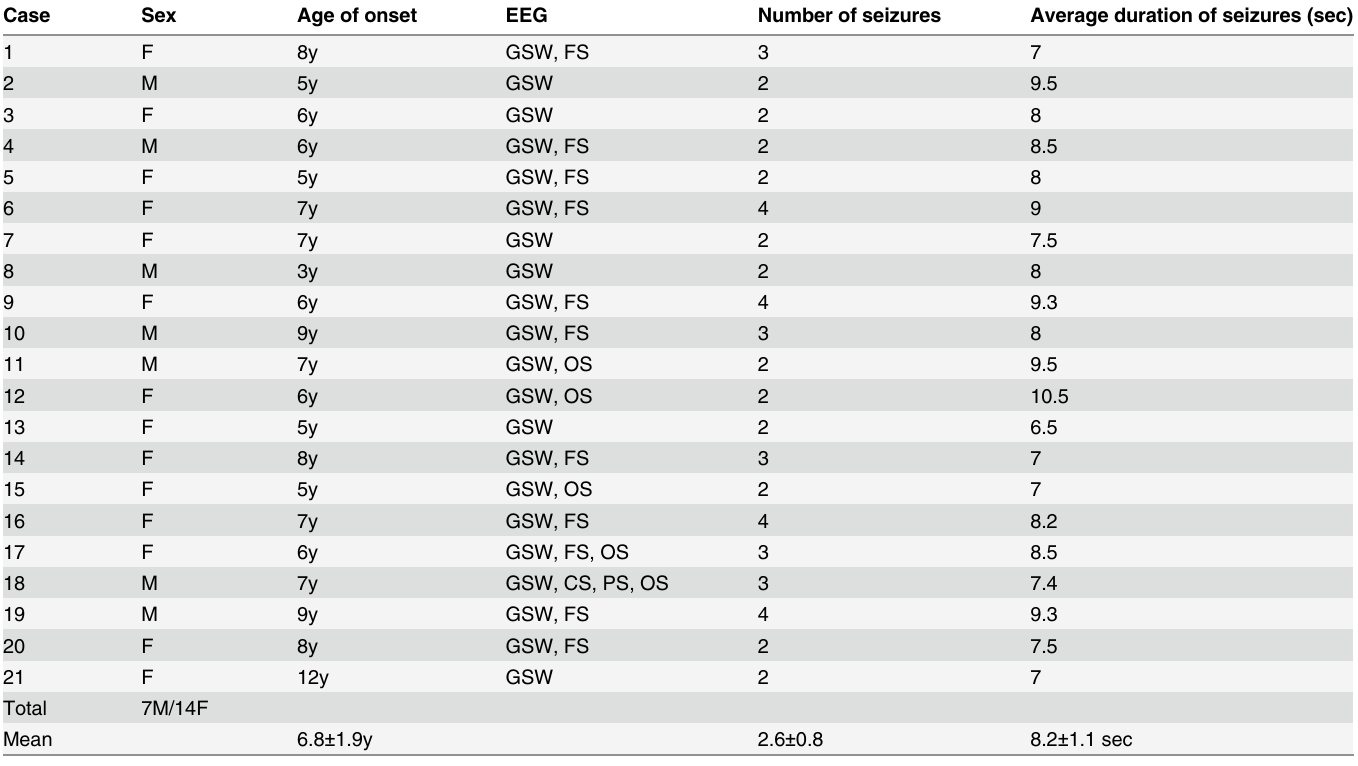
Table 1. Demographic data of children with absence epilepsy (n = 21). The EEG was done before anti-epileptic drug was